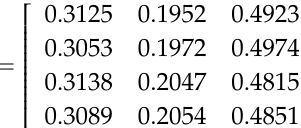
Table 3. The score values and ranking orders with di ff erent L in the q -RPDHFPWMM. Score Values L S ( α 1